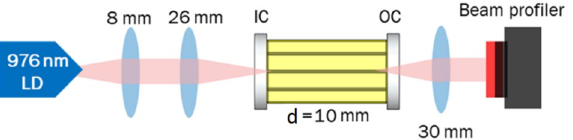
Figure 3. Laser setup to demonstrate the near-IR WG laser operation. The laser cavity consists of a HT @ 976 nm IC mirror and a 90% reflecting OC mirror @ ~ 1 μm. Cavity length is d = 10.5